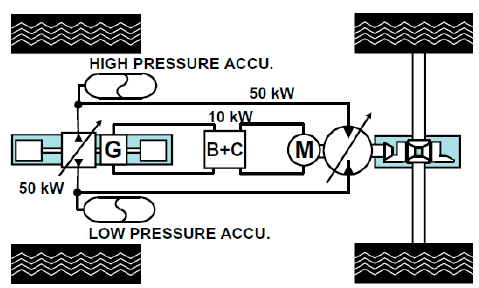
Figure 6. A machine–liquid hybrid system based on a crank-link engine [15].